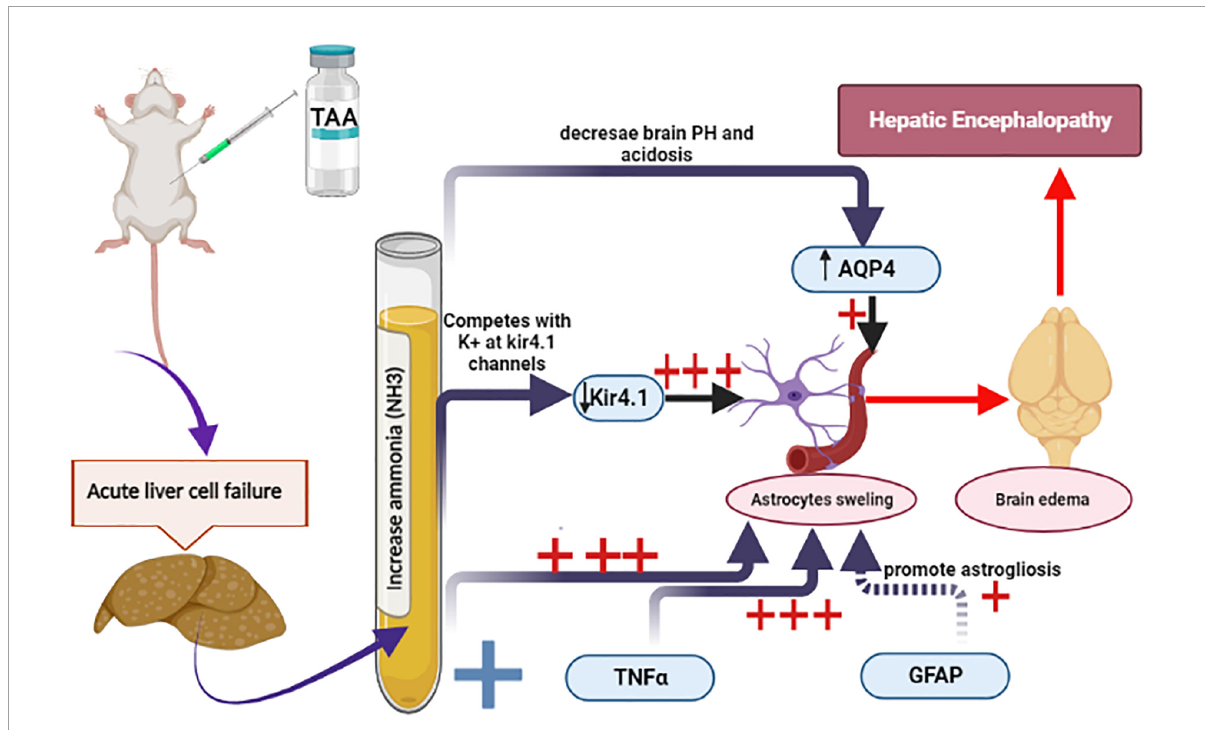
FIGURE14 Schematic diagram summarizes the current experiment and the most important mechanisms involved in astrocytes swelling. Increased ammonia level and TNF α and decreased Kir 4.1 expression were the most prominent factors (+++) as compared with GFAP and AQP4